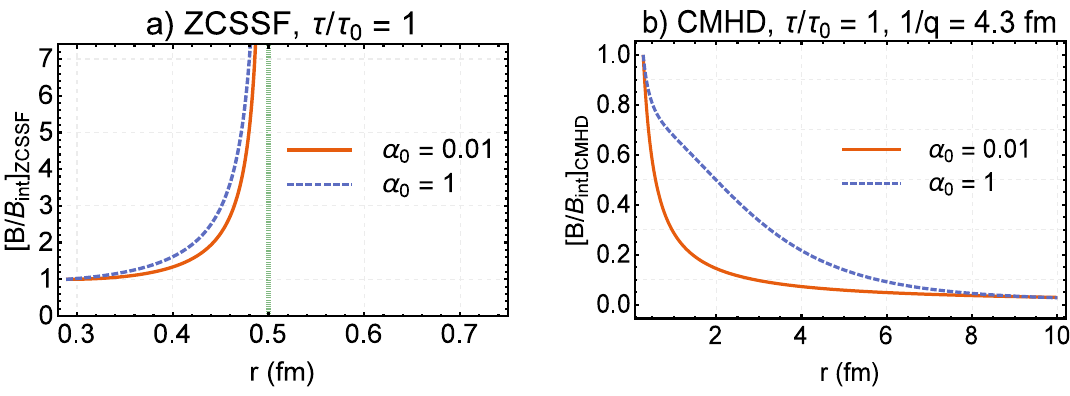
Figure 4 . (color online). The r dependence of B/B init. for the ZCSSF solution (panel a) and the CMHD solution (panel b) is plotted at τ = τ 0 and for α 0 = 0 . 01 (solid orange curves) and α 0 = 1 (dashed blue curves). For the CMHD solution q is chosen to be q = 1 / 4 . 3 fm − 1 . Whereas B ZCSSF blows up as r τ (this is indicated by the vertical green line in panel a), B CMHD is finite in the → whole range of r . For the latter case, the decay of B is slower for the initial magnetic field having a larger component along the beamline (larger α 0